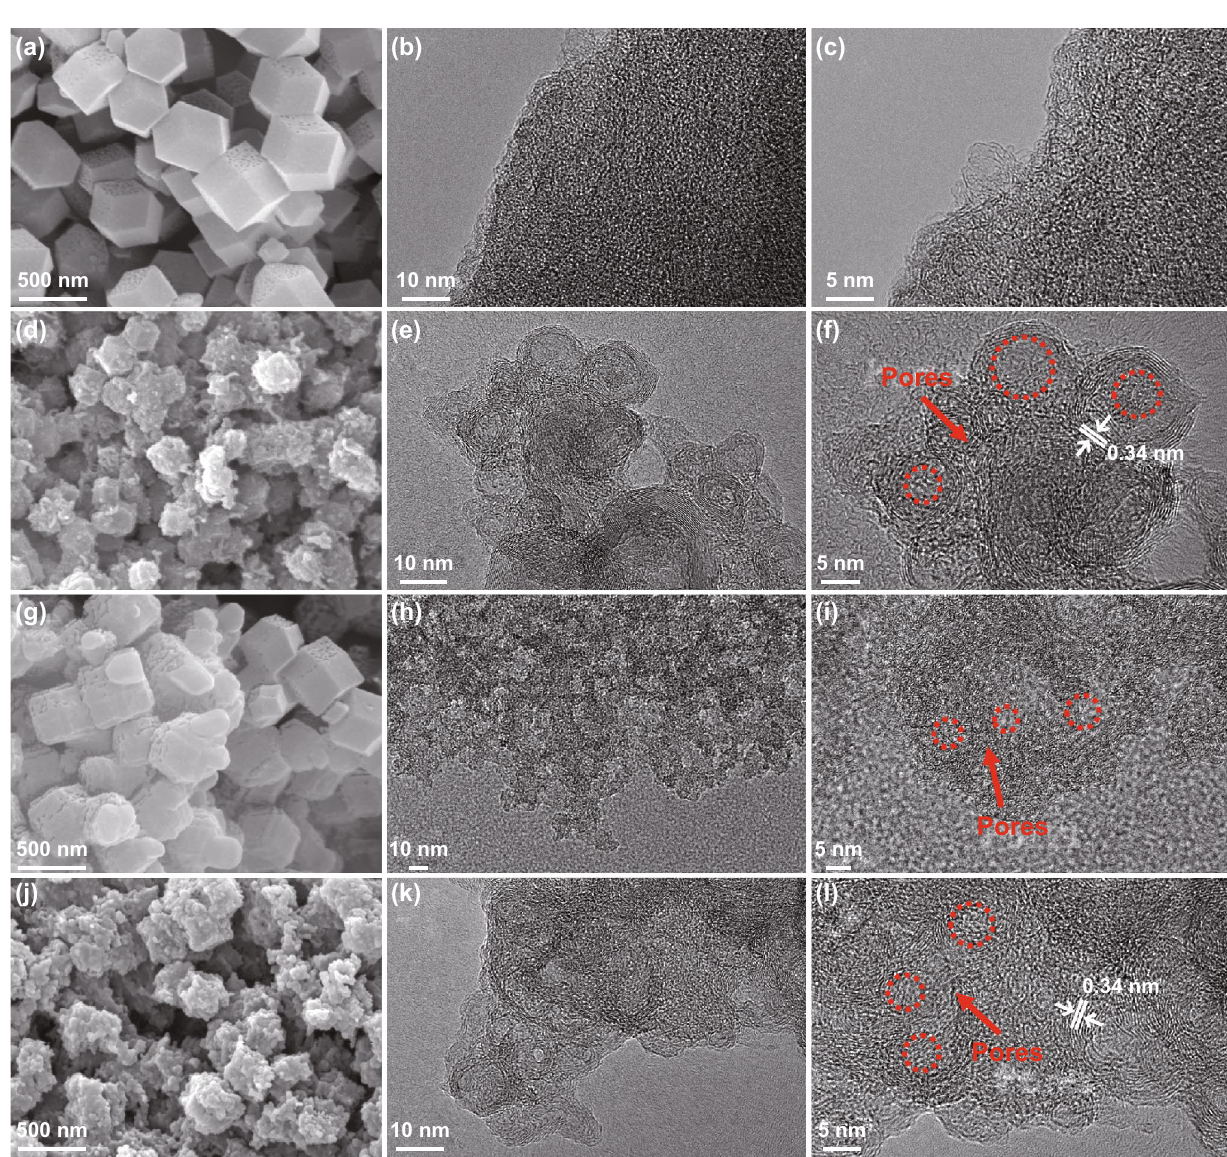
Fig. 3 SEM and HRTEM images of a-c Zn 100 ‑PC, d-f Co 100 ‑PC, g-i Zn 100 ‑APC and j-l Co 100